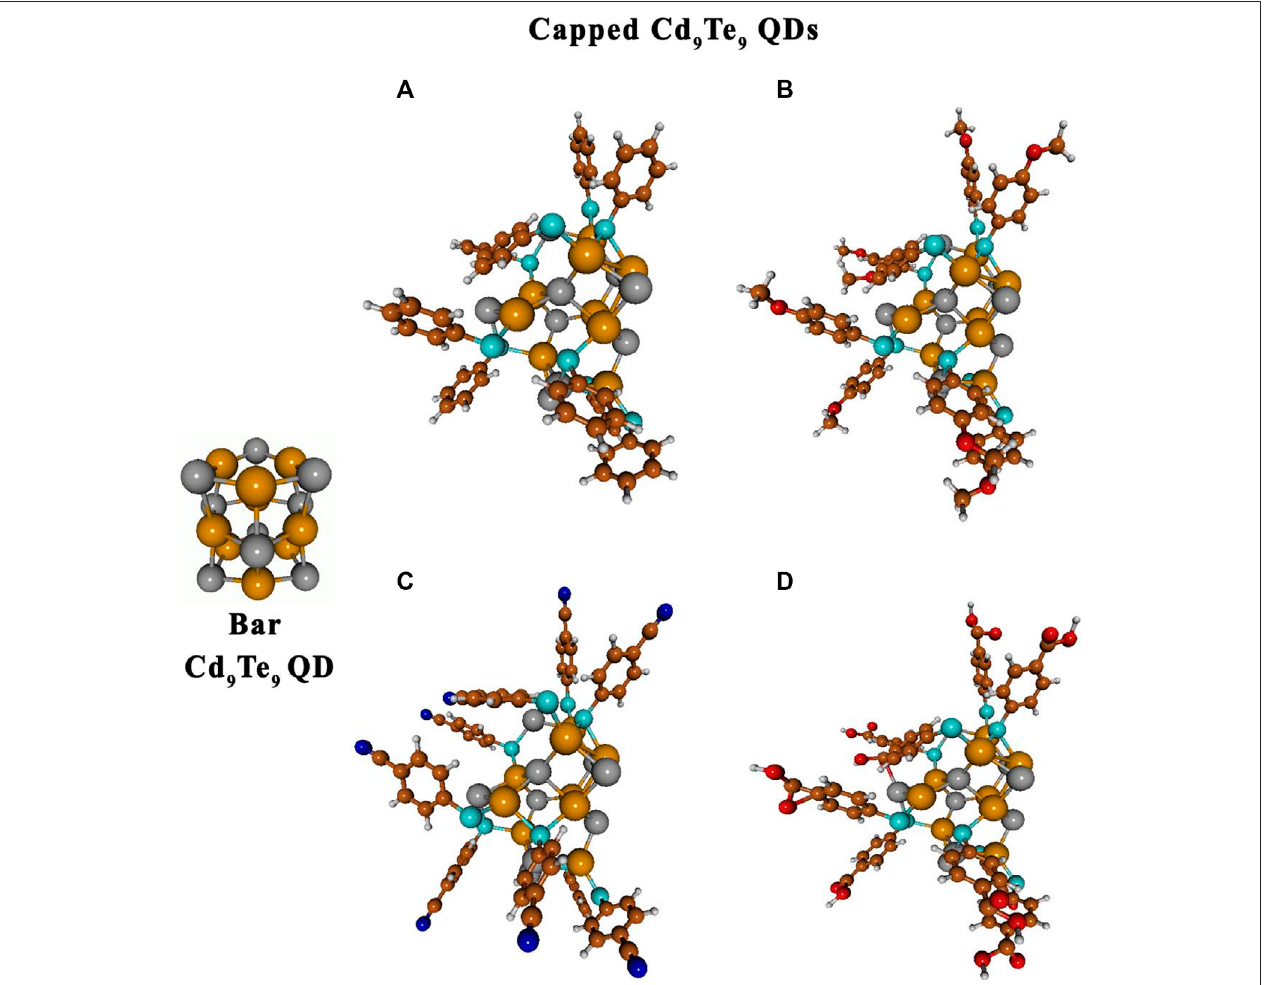
FIGURE 5 | Optimized gas-phase structures of bare and capped Cd 9 Te 9 QDs: Cd 9 Te 9 (TP) 9 (A) , Cd 9 Te 9 (MBT) 9 (B) , Cd 9 Te 9 (MBN) 9 (C) , and Cd 9 Te 9 (MBA) 9 (D) . Atomsarerepresentedasfollows:Cdbydarkyellowspheres,Tebydarkgrayspheres,Cbrownspheres,Hlightgraysphere,Oredspheres,Ssapphirespheres,andN blue spheres.